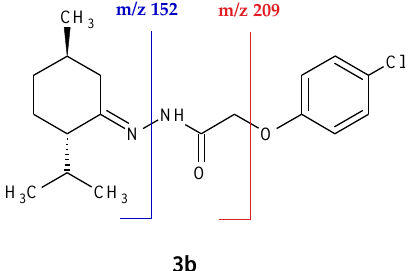
Figure 1. Mechanism of hydrazone 3b fragmentation: Z -isomer (blue line), E -isomer (red line).